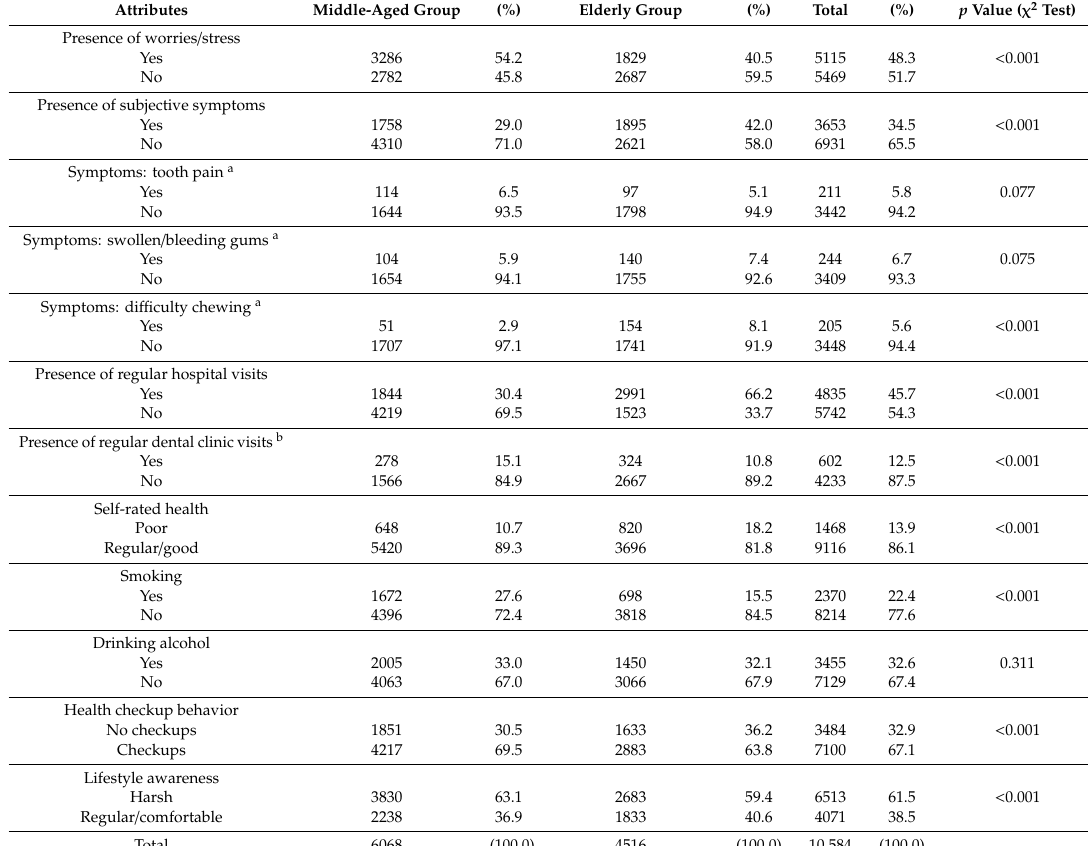
Table 2. Responses by subject